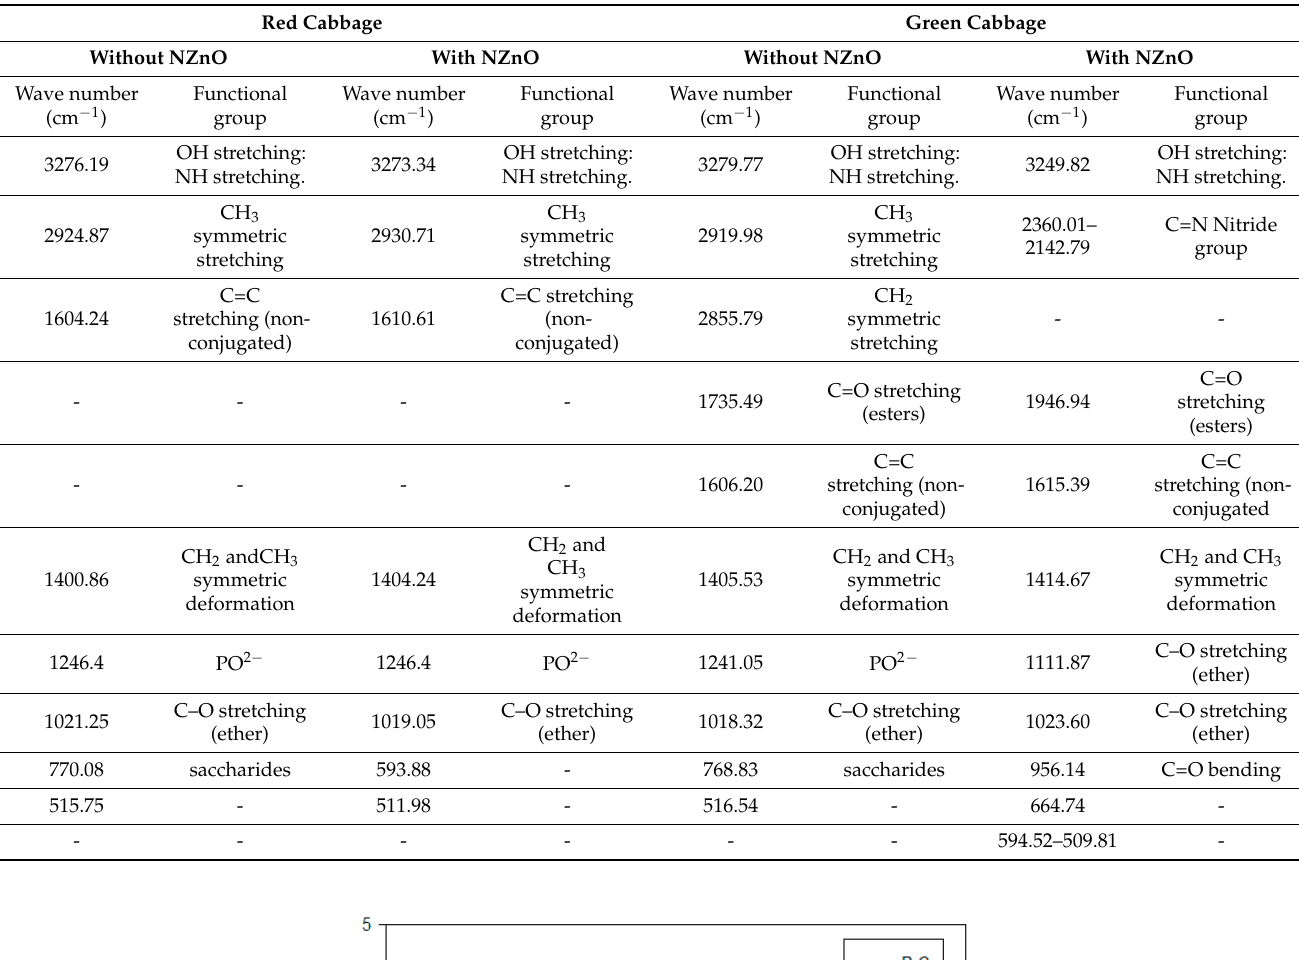
Table 1. GC and RC wave numbers and their functional groups.